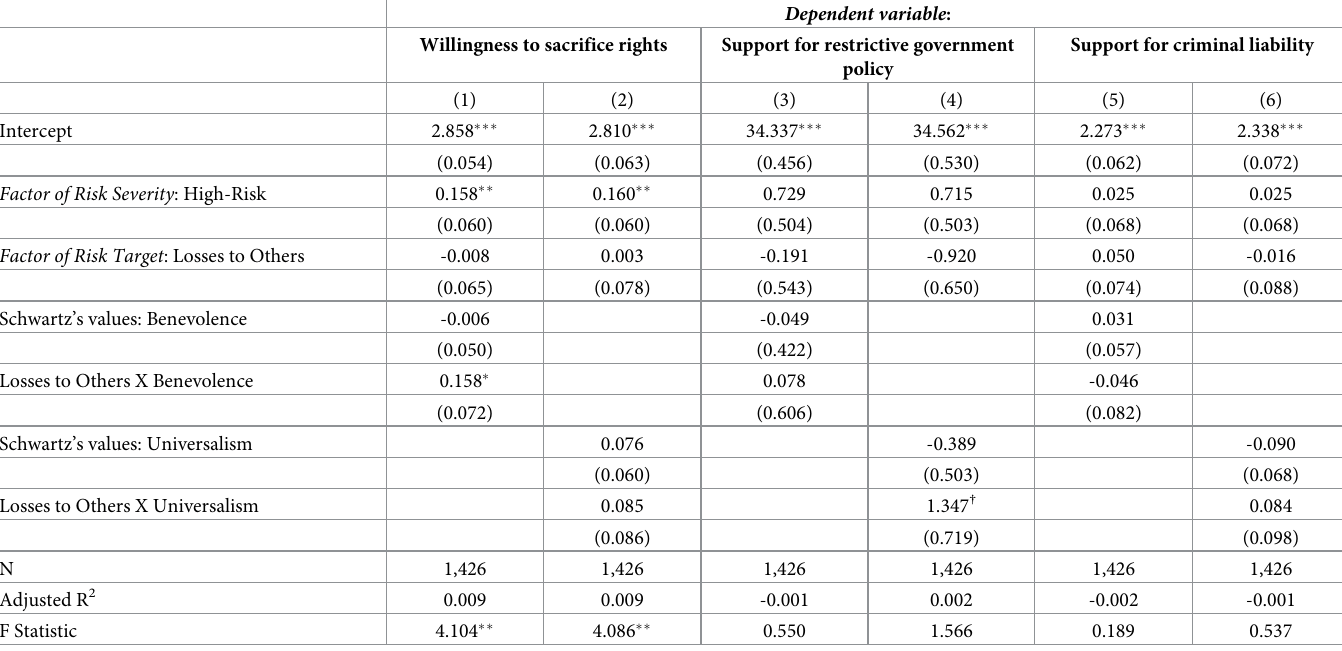
Table 9. OLS regression models estimates of CATEs using values as moderators; pre-treatment covariates as controls are not included.